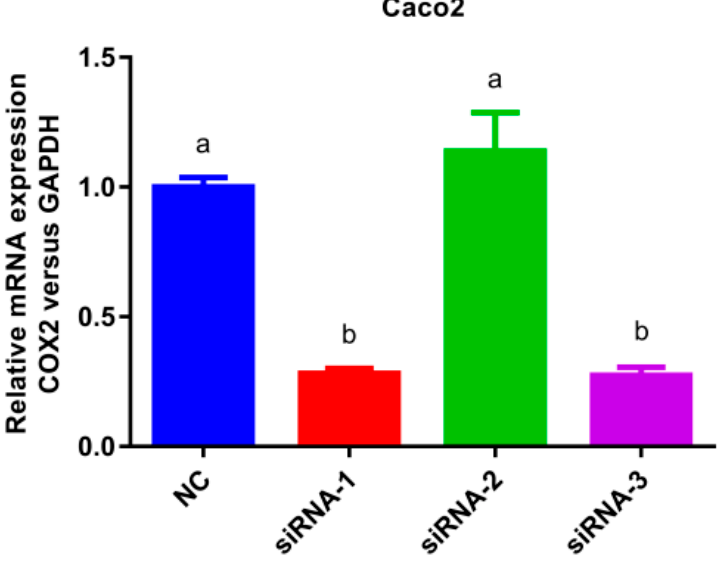
Figure 5. Histogram of mRNA expression after cyclooxygenase-2 (COX-2) silencing. Values without a common letter were significantly different as p < 0.05. Glyceraldehyde-3-phosphate dehydrogenase (GAPDH) was set as loading control, normal cells group (NC) was set as control group.